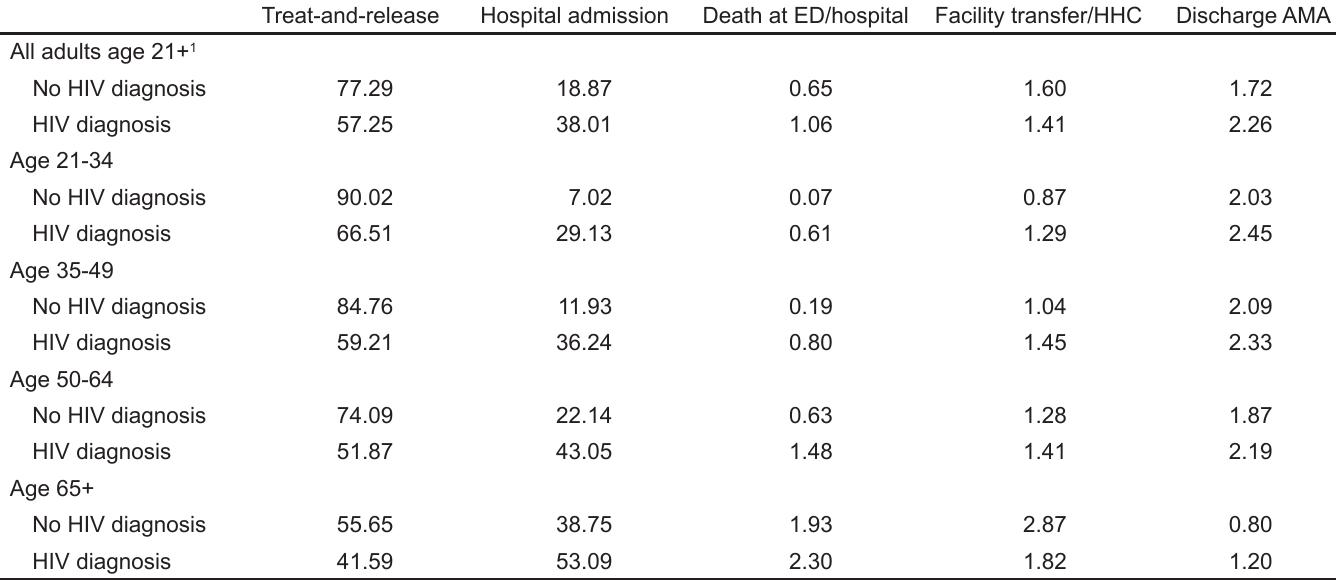
ED, emergency department; HHC, home healthcare; AMA, against medical advice; HIV, human immunodeficiency virus 1 N=23,100,490 visits without HIV diagnosis and N=115,578 visits with HIV diagnosis; other/unknown outcomes (0.13% of total without HIV and 0.06% of total with HIV) were excluded from analysis. Differences by HIV diagnosis status in each age group are significant at p<0.0001.